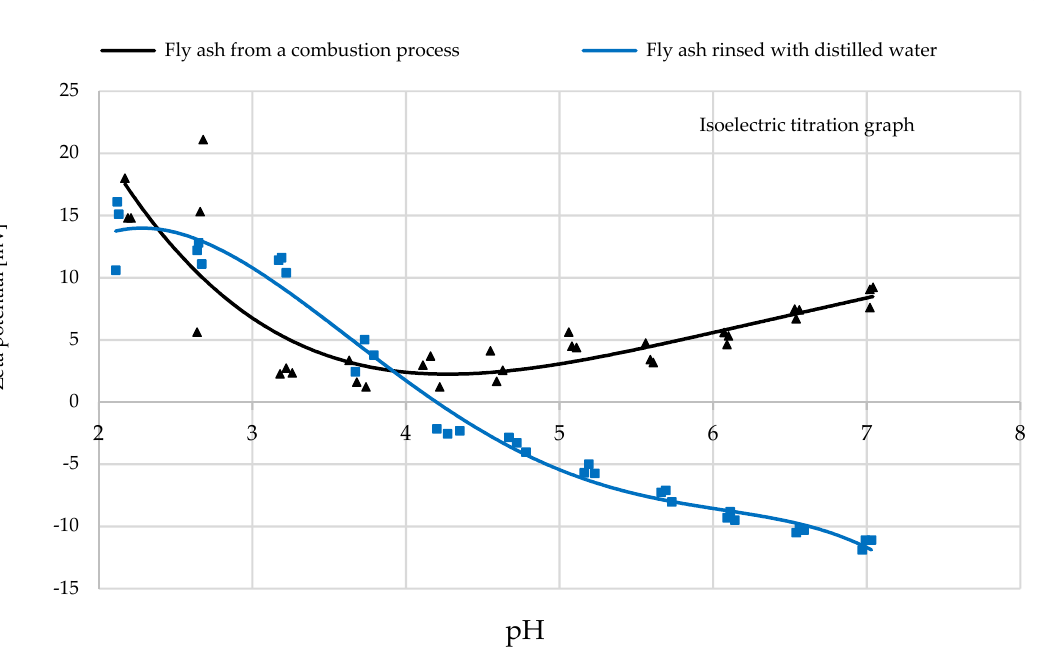
Figure 3. Plots of zeta potential vs. equilibrium pH.